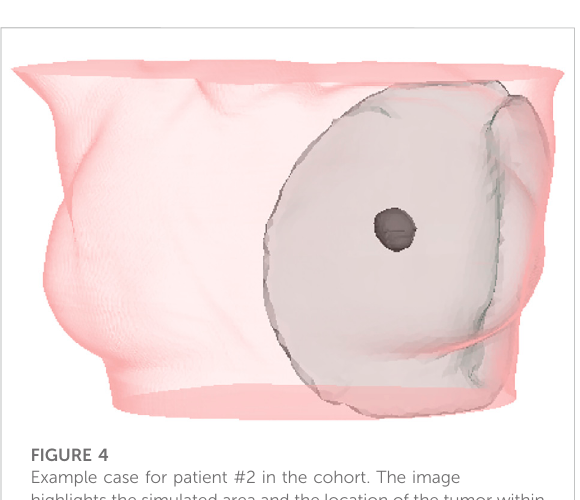
FIGURE 4 Example case for patient #2 in the cohort. The image highlights the simulated area and the location of the tumor within the